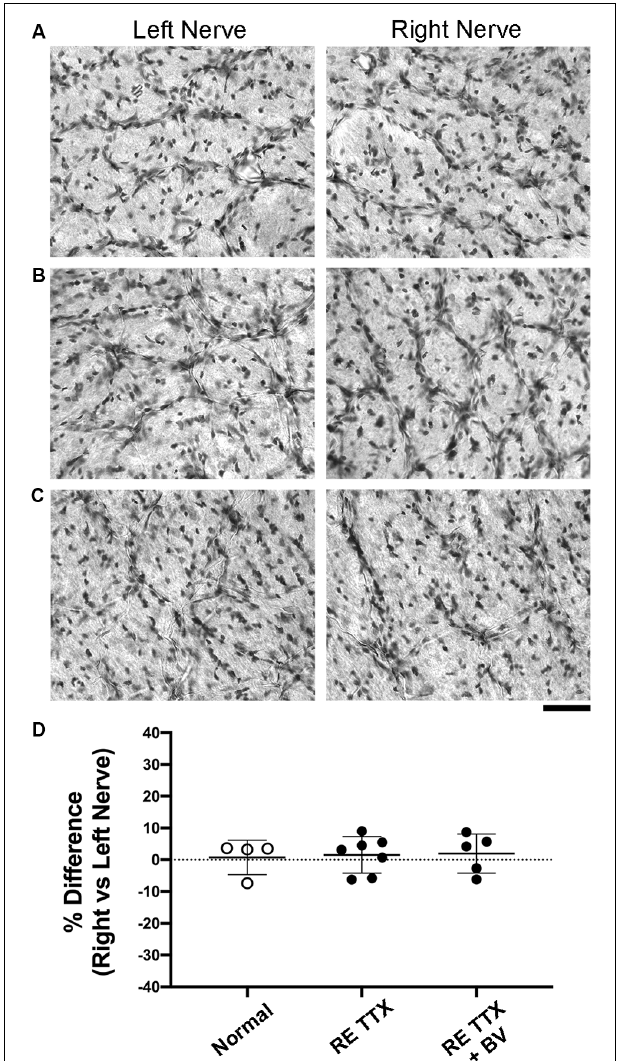
FIGURE 5 | Stereological quantification of glial cell density in cross-sections of the left and right optic nerves. Glial cells were revealed with a stain for Nissl substance and in normal animals, the density and distribution of cells appeared equal across the left and right optic nerves (A) . Following 10 days of retinal inactivation, the left and right optics nerves maintained a normal appearance concerning the number and distributions of stained cells (B) , and similarity between nerves was also found after inactivation wore off (C) . Quantification of glial cell density (D) revealed an ocular dominance balance that was not different across groups ( H = [3] = 0.66, p = 0.74; Dunn’s multiple comparison test: p > 0.05). between left and right eyes [ H = (6) = 3.71, p = 0.59; Dunn’s